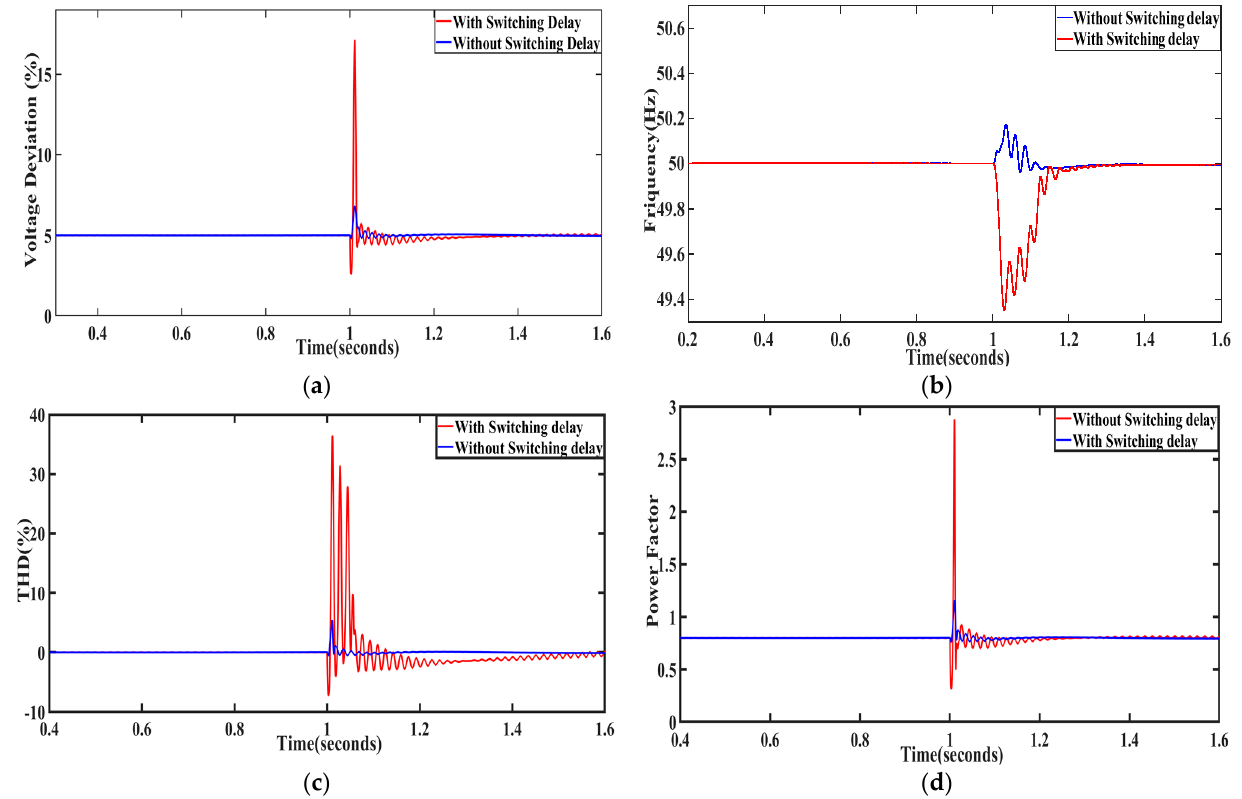
Figure 18. ( a ). Influence of switching delay on deviation of voltage. ( b ) Effect of switching delay on THD. ( c ) Effect of switching delay on frequency. ( d ) Effect of switching delay on PF.